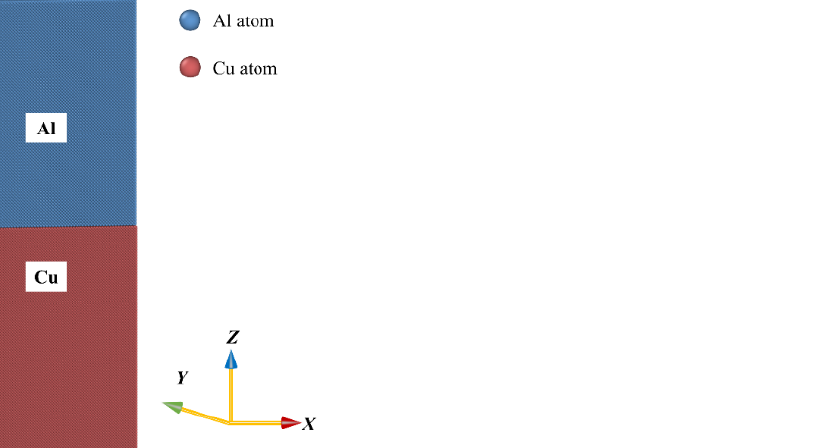
Figure 6. The sketches of the initial atomic model for the Al–Cu interface before diffusion (The contact surface is (001) plane).